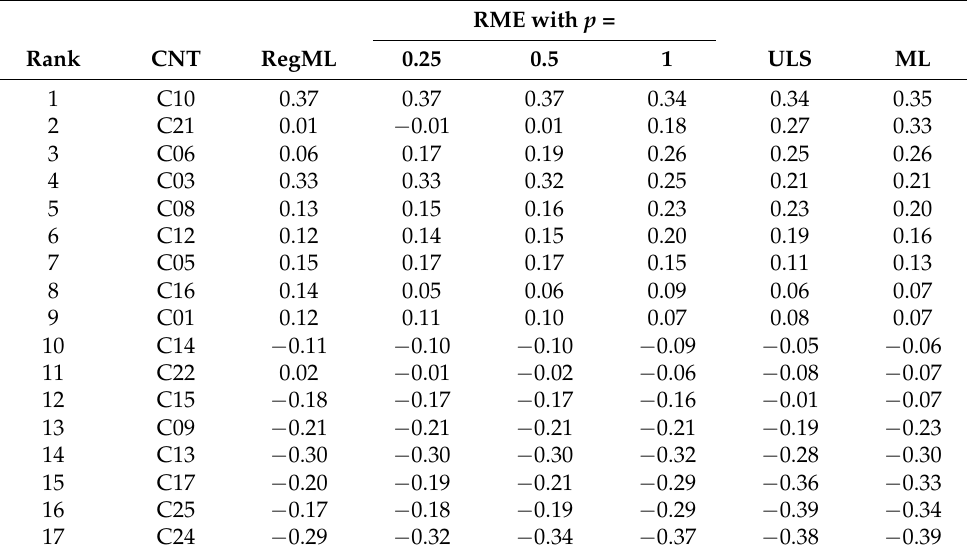
Table 4. Empirical example: Estimated country means for different estimation